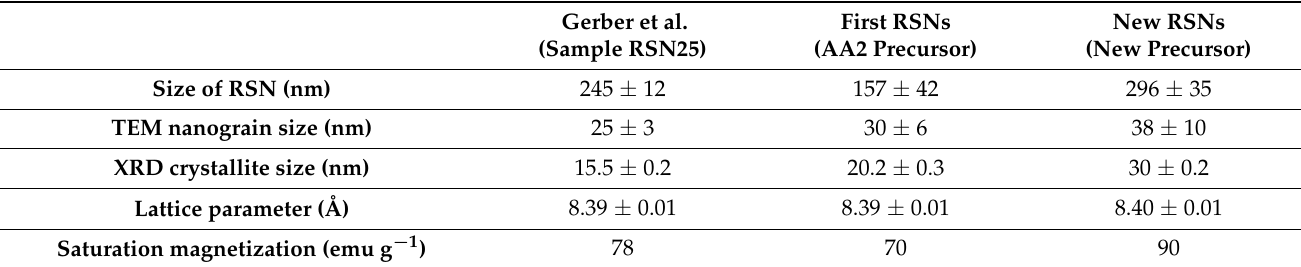
Table 4. Comparison of the RSNs synthesized with different iron precursors. Gerber et al. (Sample